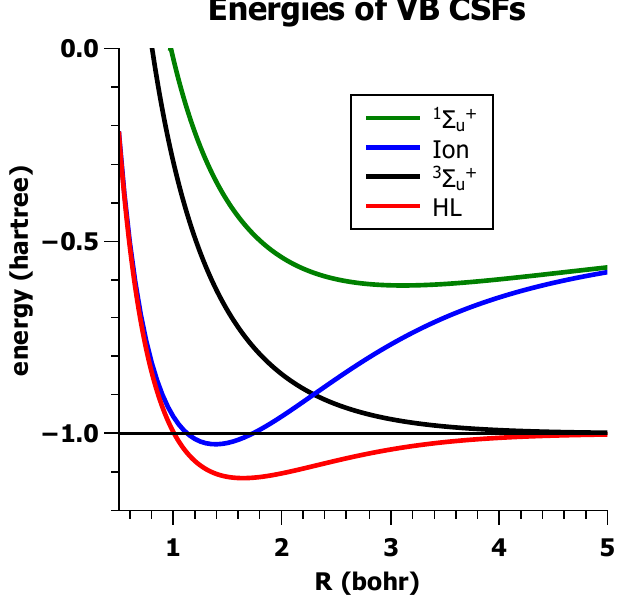
Figure 18. The energies of the four VB wave